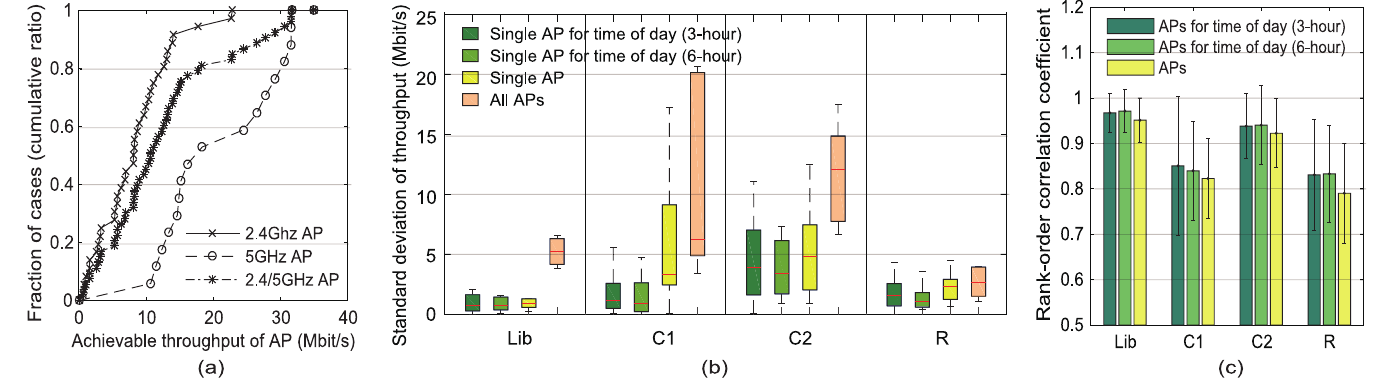
Fig 2. Cumulative distribution functions, standard deviation, and rank-order correlation coefficient. (a) cumulative distribution functions for the achievable throughputs of usable APs and the (b) standard deviation and (c) rank-order correlation coefficient of these achievable throughputs at each location.